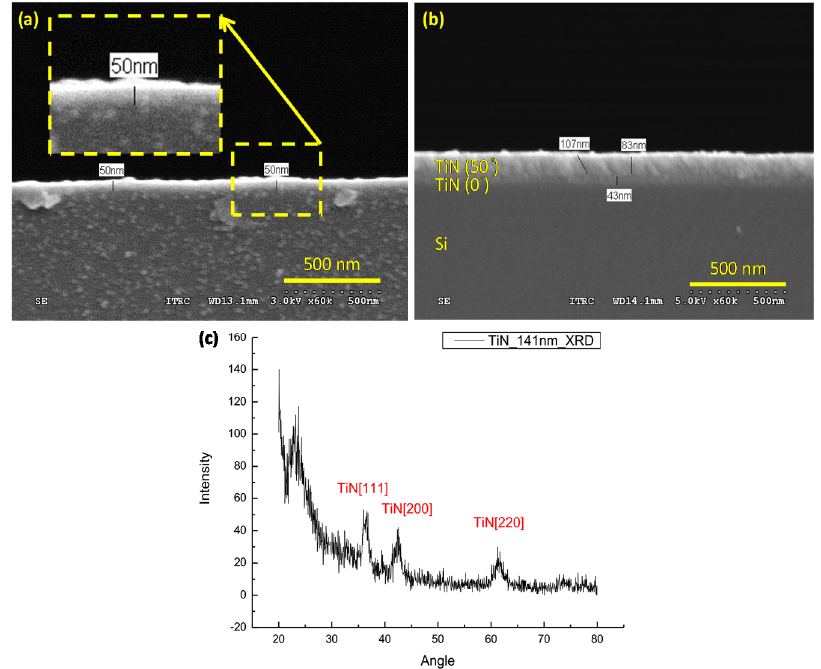
Figure 1. Scanning electron microscopy images of the TiN layer deposited on a Si substrate at various deposition angles: ( a ) 0° (50 nm) and ( b ) 0° (43 nm)/50° (83 nm). ( c ) X-ray diffraction measurement of deposited TiN (141 nm) on the Si substrate.